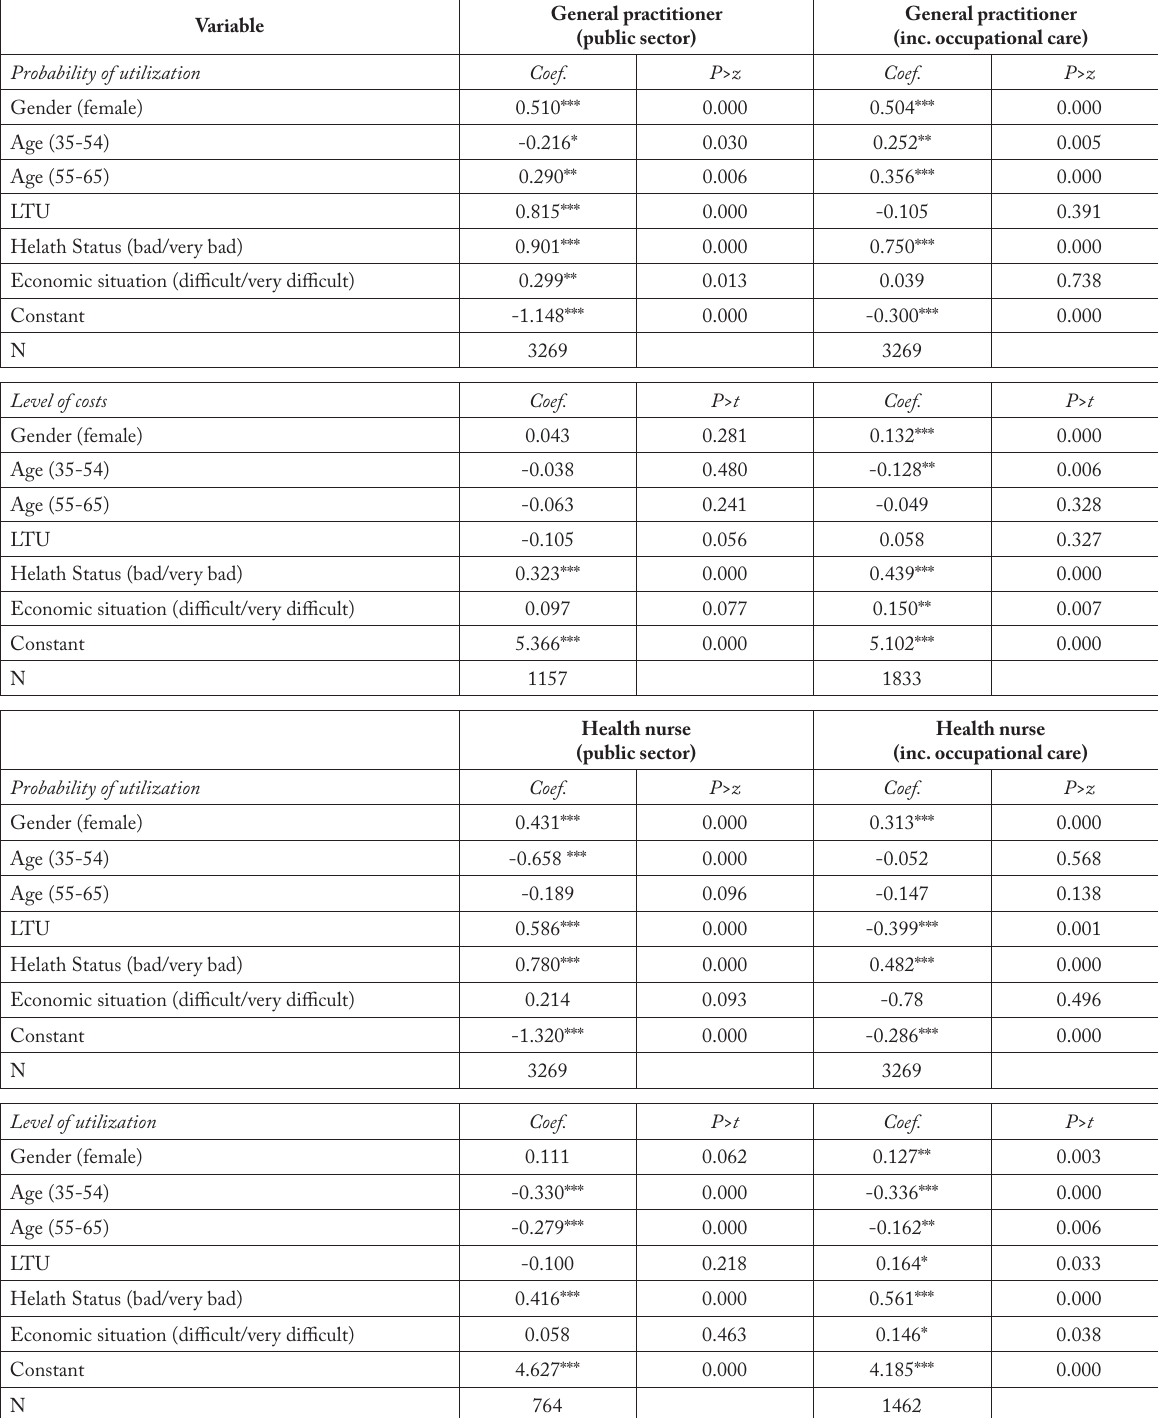
Table 3. Estimation results of the probability (logit) and level models